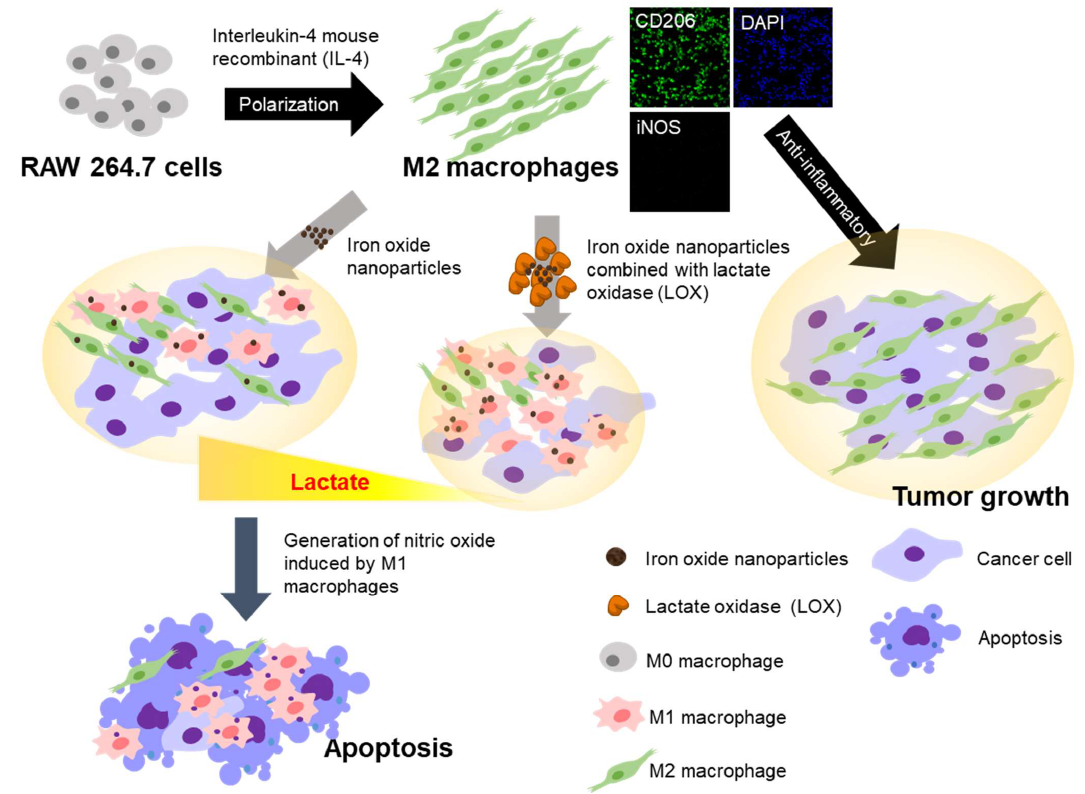
Figure 1. Concept of iron oxide nanoparticles combined with lactate oxidase (LOX) for synergistic effects on the distribution of macrophages. LOX specifically oxidized lactate in the tumor microenvironment, and the cellular uptake of iron oxide nanoparticles converted tumor-promoting M2 macrophages to tumor-suppressing M1